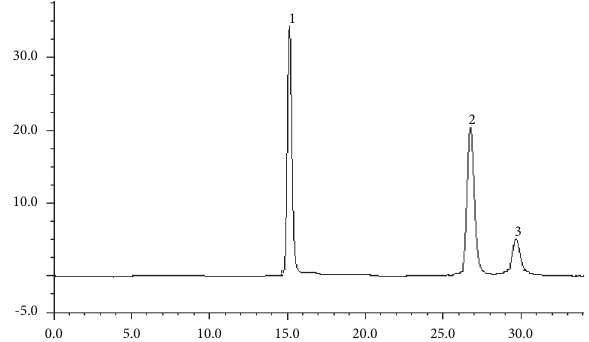
Figure 4: HPLC chromatograms of reference substance. Note: 1, euphorbia factor L3; 2, euphorbia factor L1; 3, euphorbia factor